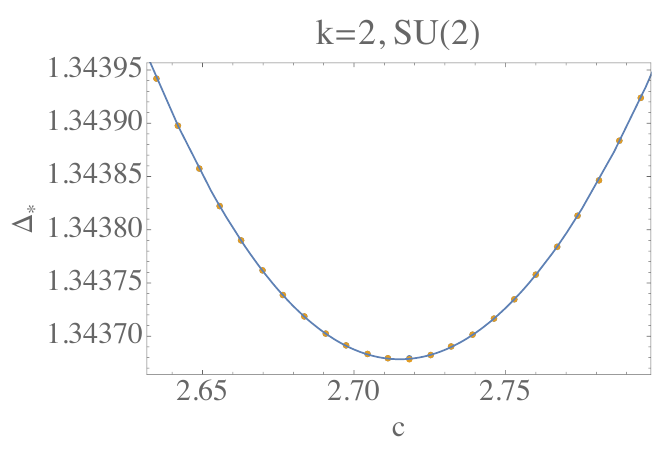
Figure 15 . Bound on the gap (cid:1) (cid:3) to the lightest neutral state for SU(2) at level k = 2. The bound is minimized at c (cid:25) 2 : 715.